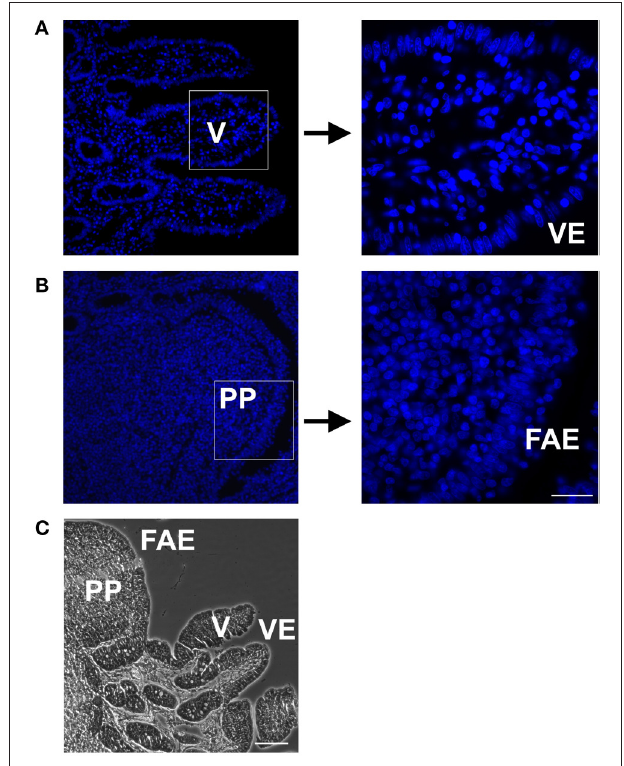
FIGURE 2 | DAPI staining of Peyer’s patch follicle associated epithelium (PP FAE) compared to neighboring villi (V) with villous epithelium (VE), and Hematoxylin and Eosin (HE) staining. (A) VE (B) PP FAE Tissue specimen; magnification 20 × , marked squares are shown in 63 × magnification (C) HE staining representing PP with FAE, and neighboring V with VE (bar: 50 µ